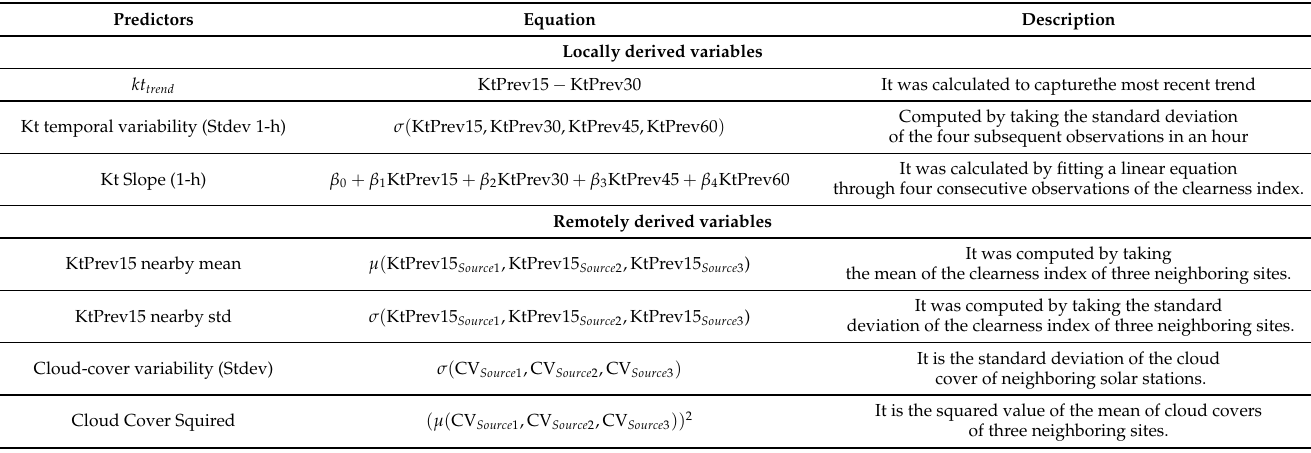
Table 3 lists all locally and remotely derived variables. Table 3. Variables used for K-medioid